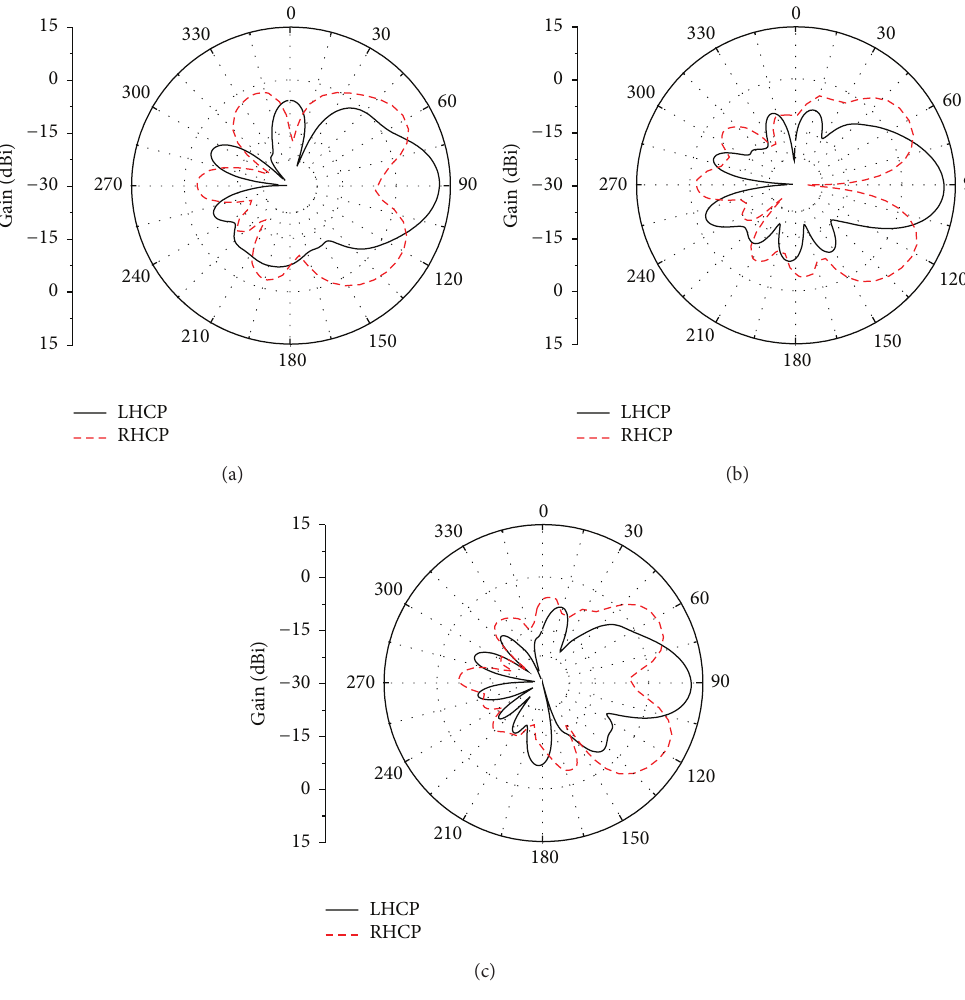
Figure 5: Simulated radiation patterns of antenna array at (a) 5 GHz, (b) 6GHz, and (c) 7GHz.